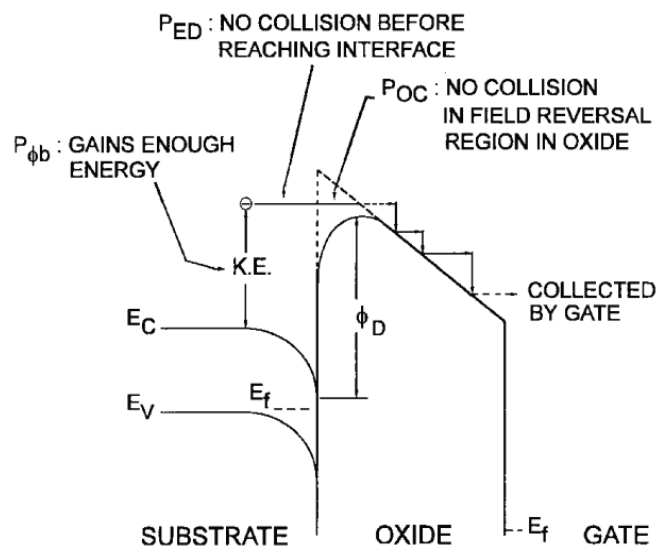
Figure 11. A schematic energy band diagram describing the three processes involved in electron injection. Reused with permission from [34], Copyright 1997,